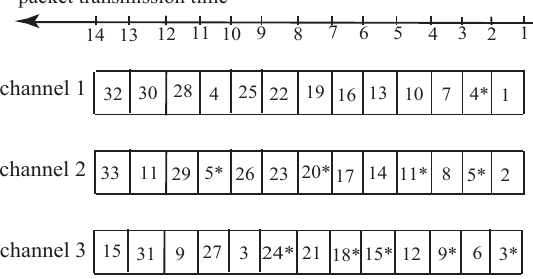
Figure 3. Dynamic Channel Scheduling ( M = 3; τ = 3 )